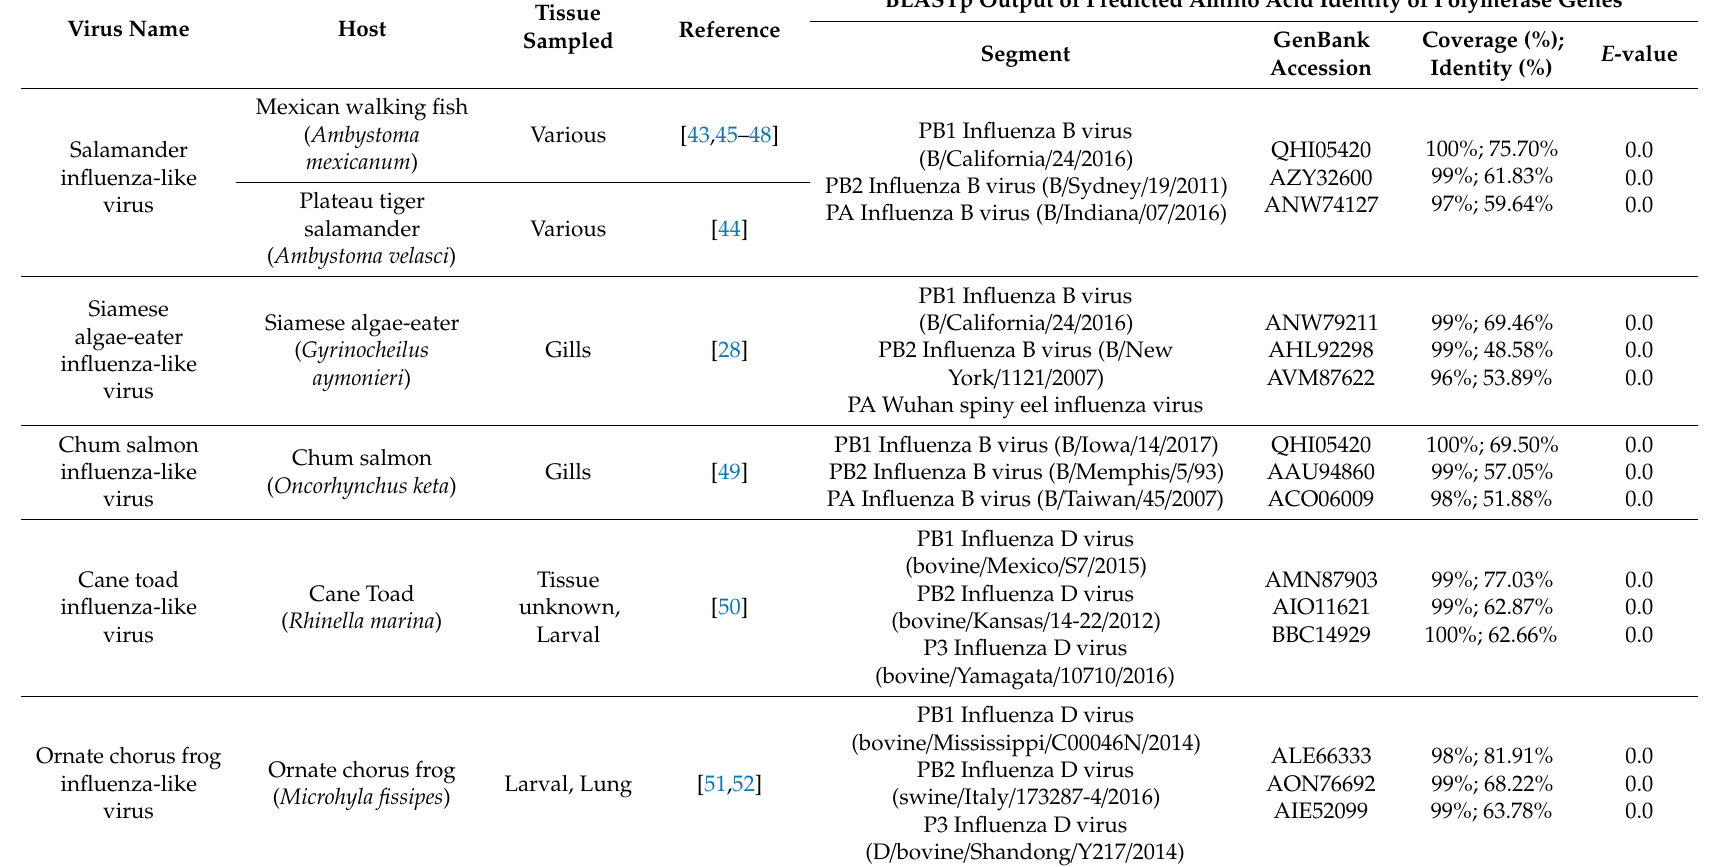
Table 1. Metadata for the novel influenza viruses identified in this